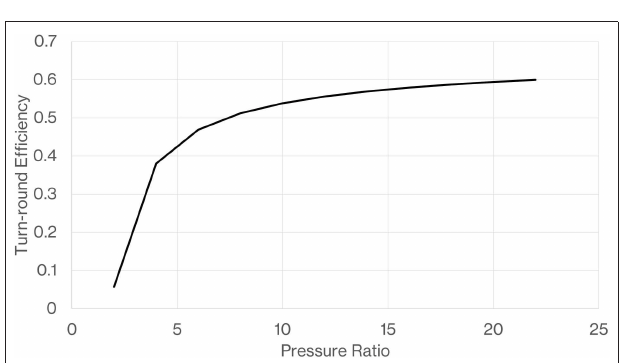
FIGURE 21 | Influence of pressure ratio on maximum and minimum thermal store